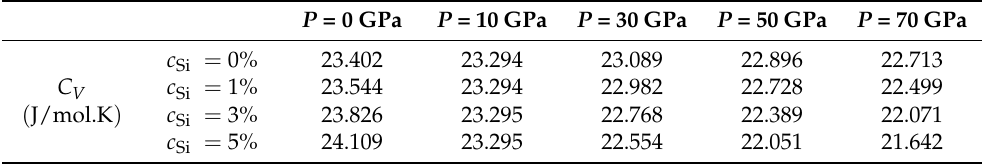
Table 5. Si concentration and pressure dependence of specific capacity at constant volume C V ( J/mol.K ) for WSi at T = 300 K.